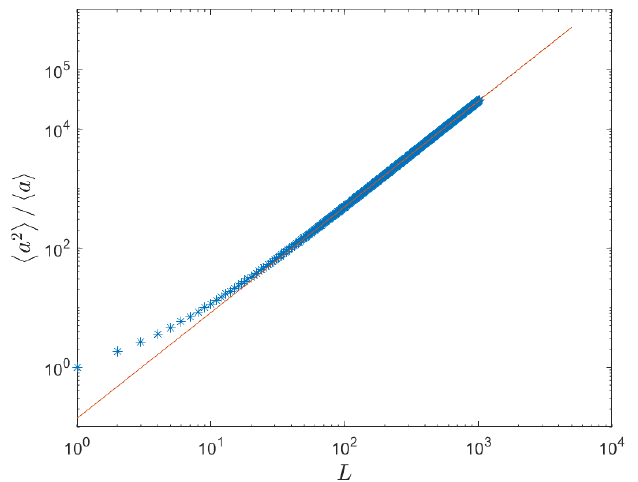
Figure 3. The value of the exponent φ has been obtained as φ ≈ 1.77 from the relation, a c = (cid:10) (cid:11) a 2 / (cid:104) a (cid:105) ∼ L φ .